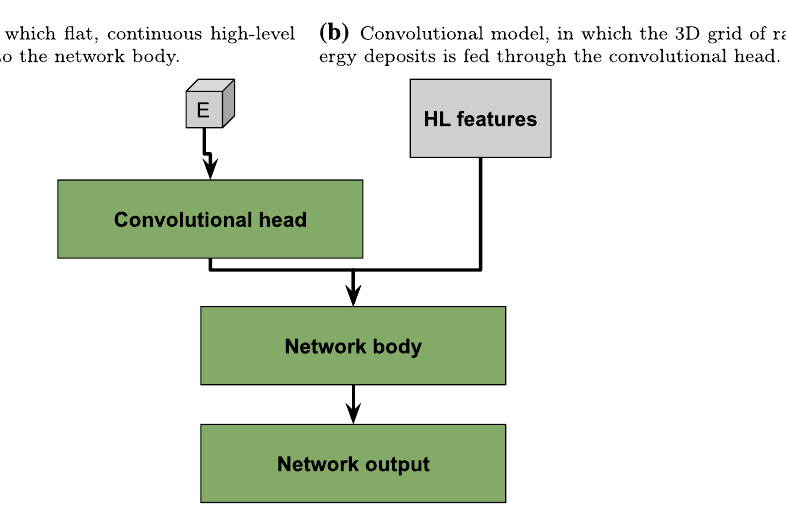
3 The CNN regression